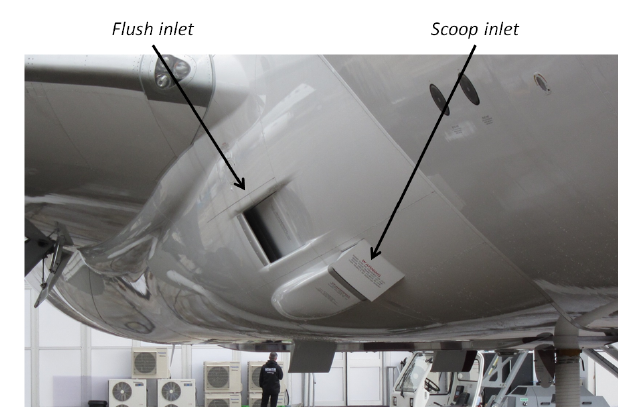
Figure 4. Air inlets of a Boeing 787 [37].